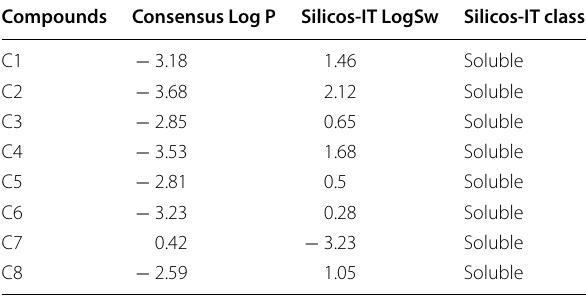
Table 2 SWISSADME-predicted lipophilicity (Log P) and water solubility (Log